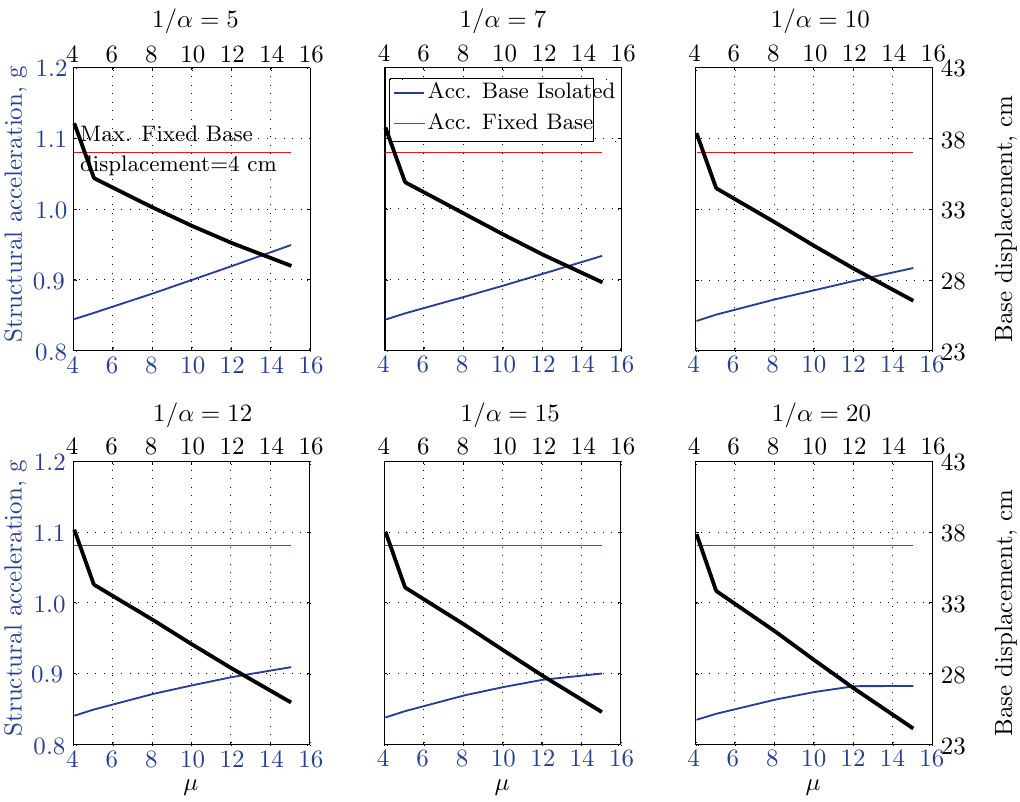
Figure 34. Peak responses of BI-structures subjected to Petrolia 1992 (Petrolia station).